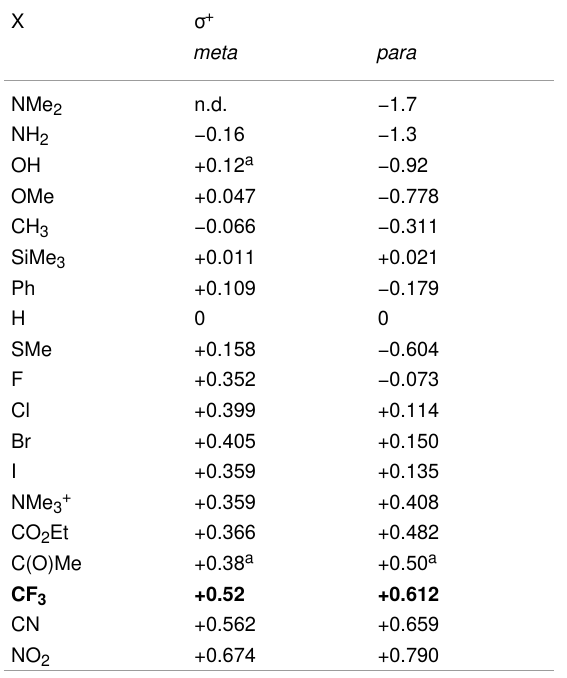
Table 1: Selection of Hammett constant σ + values for selected func- tional groups X, extracted from References [20,21].